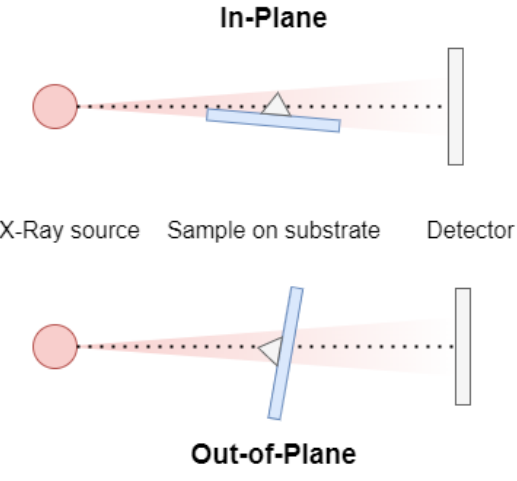
Figure 5. Illustration of shadowing of structure by glass